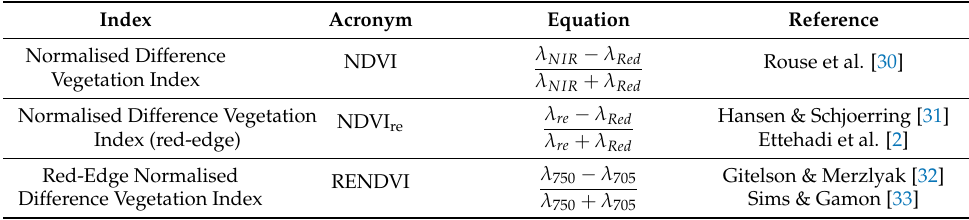
Table 1. Vegetation indices used for spatial